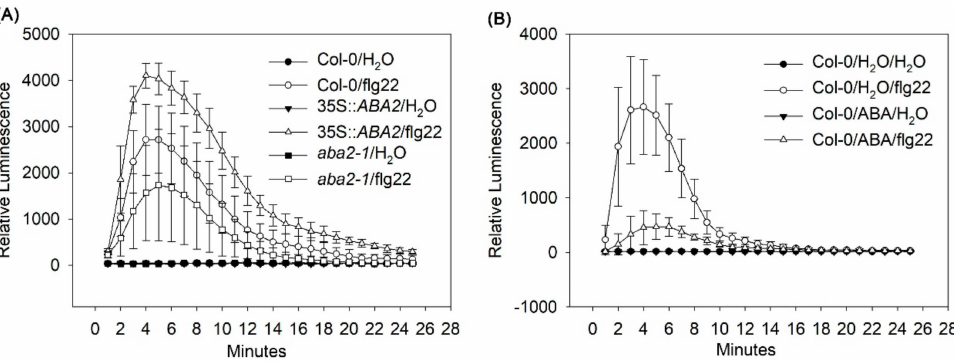
Figure 2. E ff ects of endogenous and exogenous abscisic acid (ABA) on H 2 O 2 production induced by flg22 in Arabidopsis . ( A ) Endogenous ABA and ( B ) exogenous ABA. For analyzing exogenous ABA, wild-type (Col-0) plants were treated with distilled water (H 2 O) or ABA before detecting flg22-induced H 2 O 2 production. Error bars indicate the standard error, and values were based on at least eight independent replicates. These experiments were performed at least three